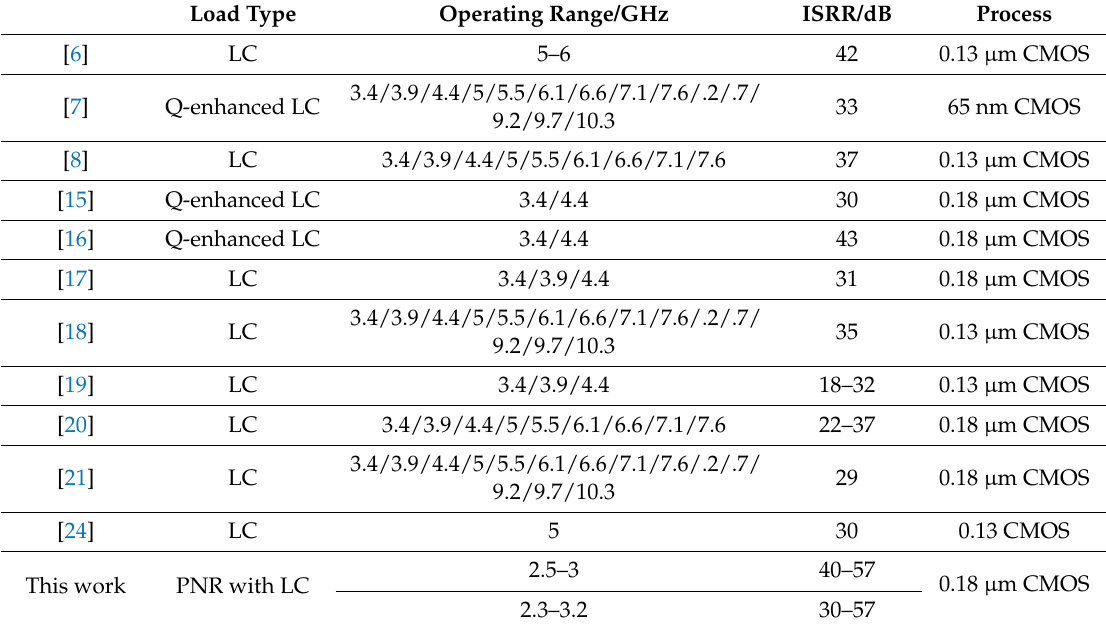
Table 2. Performance comparison with the referenced